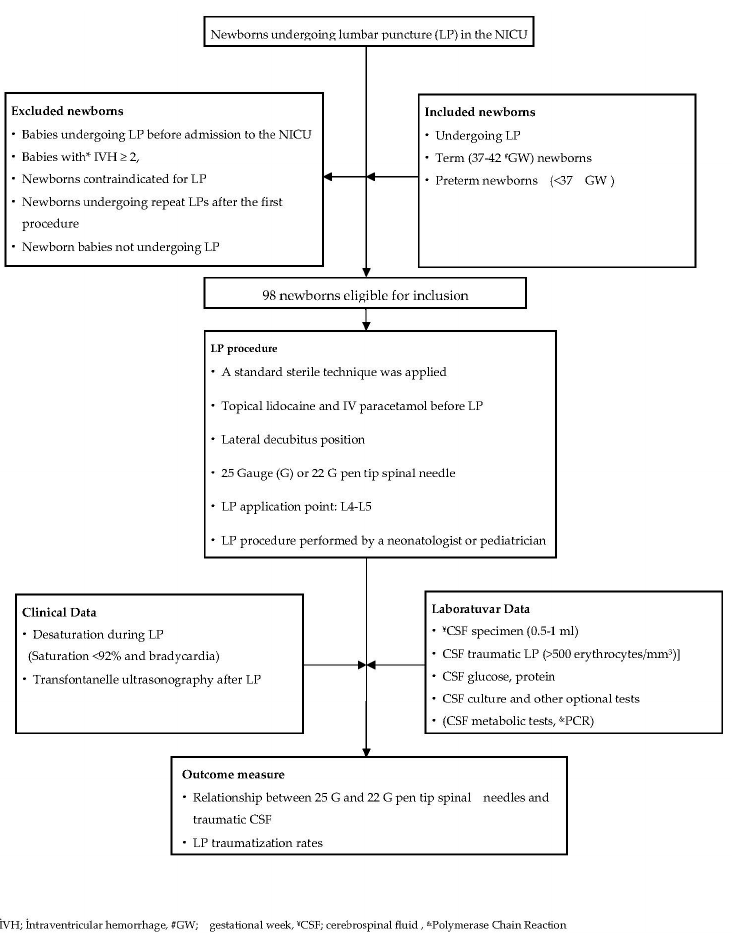
Figure 1. Flow chart of patient selection and the methods employed.